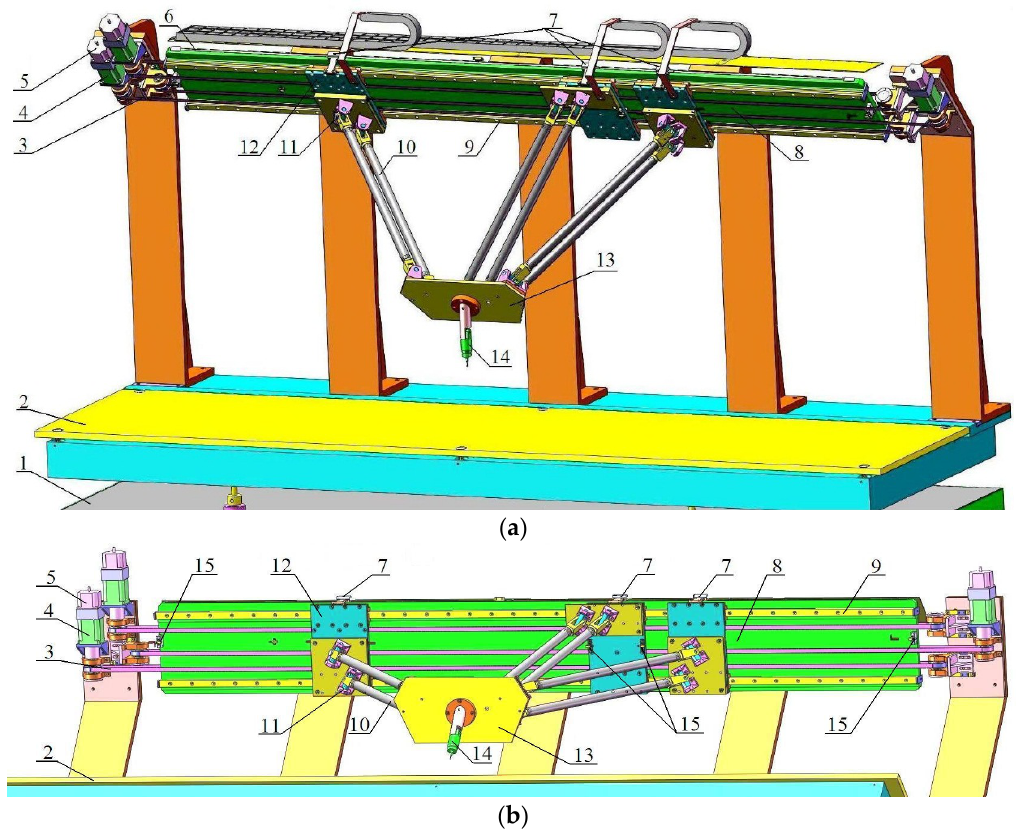
Figure 1. 3 ‐ PPU (three pairs of prismatic ‐ universal ‐ universal joints) PCMM (parallel coordinate measuring machine). (1) Base, (2) table, (3) steel belt, (4) reducer, (5) motor, (6) linear grating, (7) reading head, (8) beam, (9) linear guider, (10) rod, (11) universal joints, (12) slider, (13) moving platform, (14) measuring head, and (15) limit switch. ( a ) front view; ( b ) upward view.